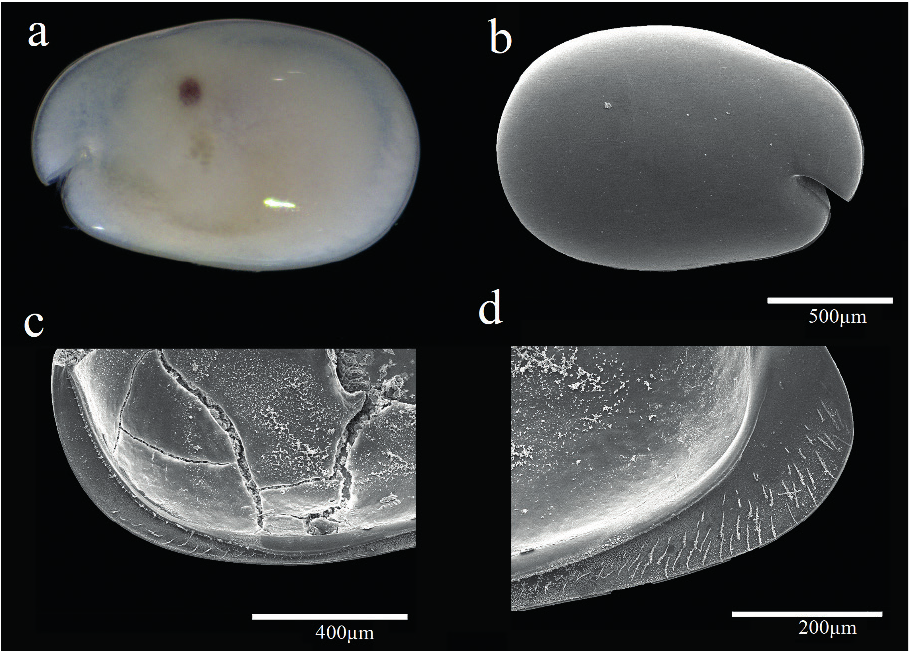
Figure 10. Light microscopy and scanning electron microscopy images of Parasterope sohi sp. nov. holo- type female adult: a External view b Lateral view from left valve c Anterior of left valve from inside show- ing bristles of